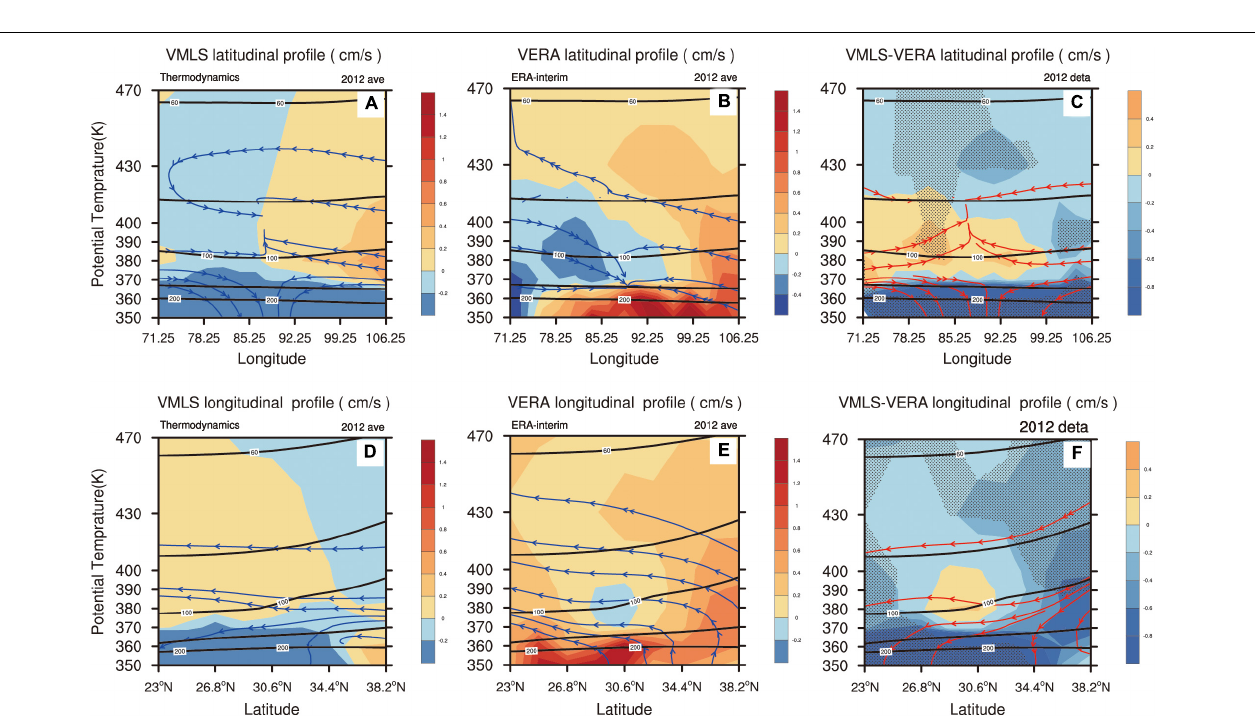
FIGURE 6 | Daily mean V MLS (A,D) , V ERA − I (B,E) and the deviation between them (C,F) for the nighttime in JJAS 2012. Panels (A–C) are the latitudinal profiles along 80.5 ◦ E and (D–F) are the longitudinal profiles along 32.5 ◦ N. The shading represents the vertical velocity field, the streamlines are the vertical and horizontal wind fields and the contour lines are the air layer. The dotted regions in panels (C,F) represent the area that passed the 95% significance test.